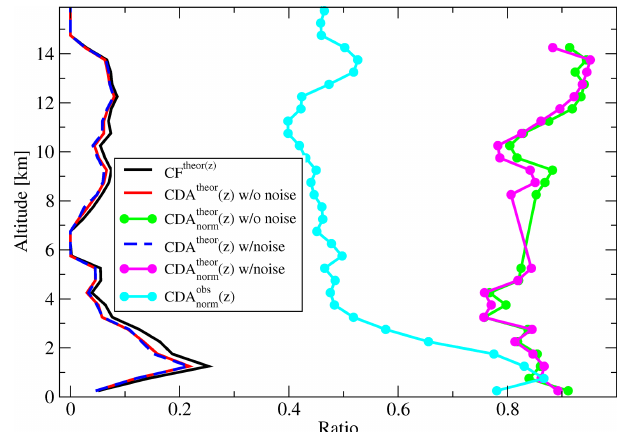
Figure 5. Estimating theoretical cloud detection agreement (CDA) using pseudo-collocated SR ( 532nm ,z) and SR (cid:48) ( 532nm ,z) profiles calculated using the COSP2 lidar simulator coupled with the out- put of the EAMv1 atmospheric model (see Fig. 3). The definitions of cloud fraction (CF), CDA, and CDA norm variables are given in Sect. 3.5. “Noise” stands for calculations considering experimental noise of CALIOP and ALADIN and diurnal variation of the clouds for the collocation (cid:49) time up to 6h (see Fig. 2). The “CDA obs norm (z) ” cyan curve comes from the analysis of real collocated data and is mentioned in Sect.